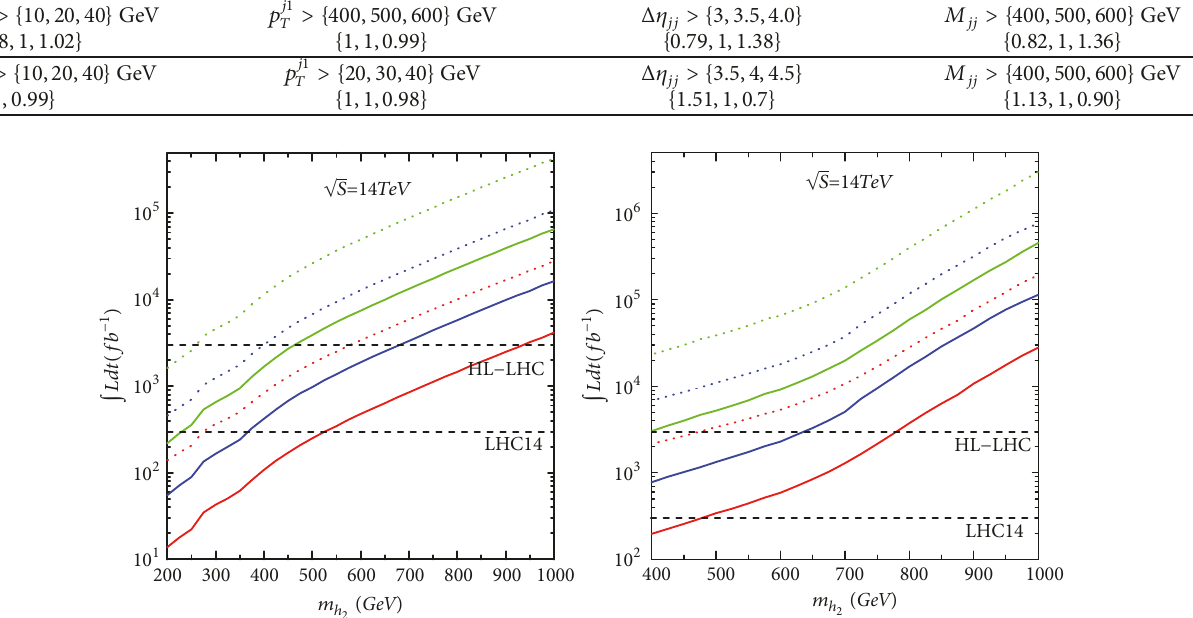
Figure 3: Theintegratedluminosity needed for the exclusiondetermined by 𝑆/√𝐵 = 1.96 (solid) and 5𝜎 discoverydetermined by 𝑆/√𝑆 + 𝐵 = 5 (dotted) at the 14 TeV LHC, respectively. Here, the left and right plot correspond to the left and right plot of Figure 1, respectively, where the meaning of colors is the same as in Figure 1. The two horizontal lines correspond to integrated luminosity of 300 fb −1 and 3000 fb −1 .